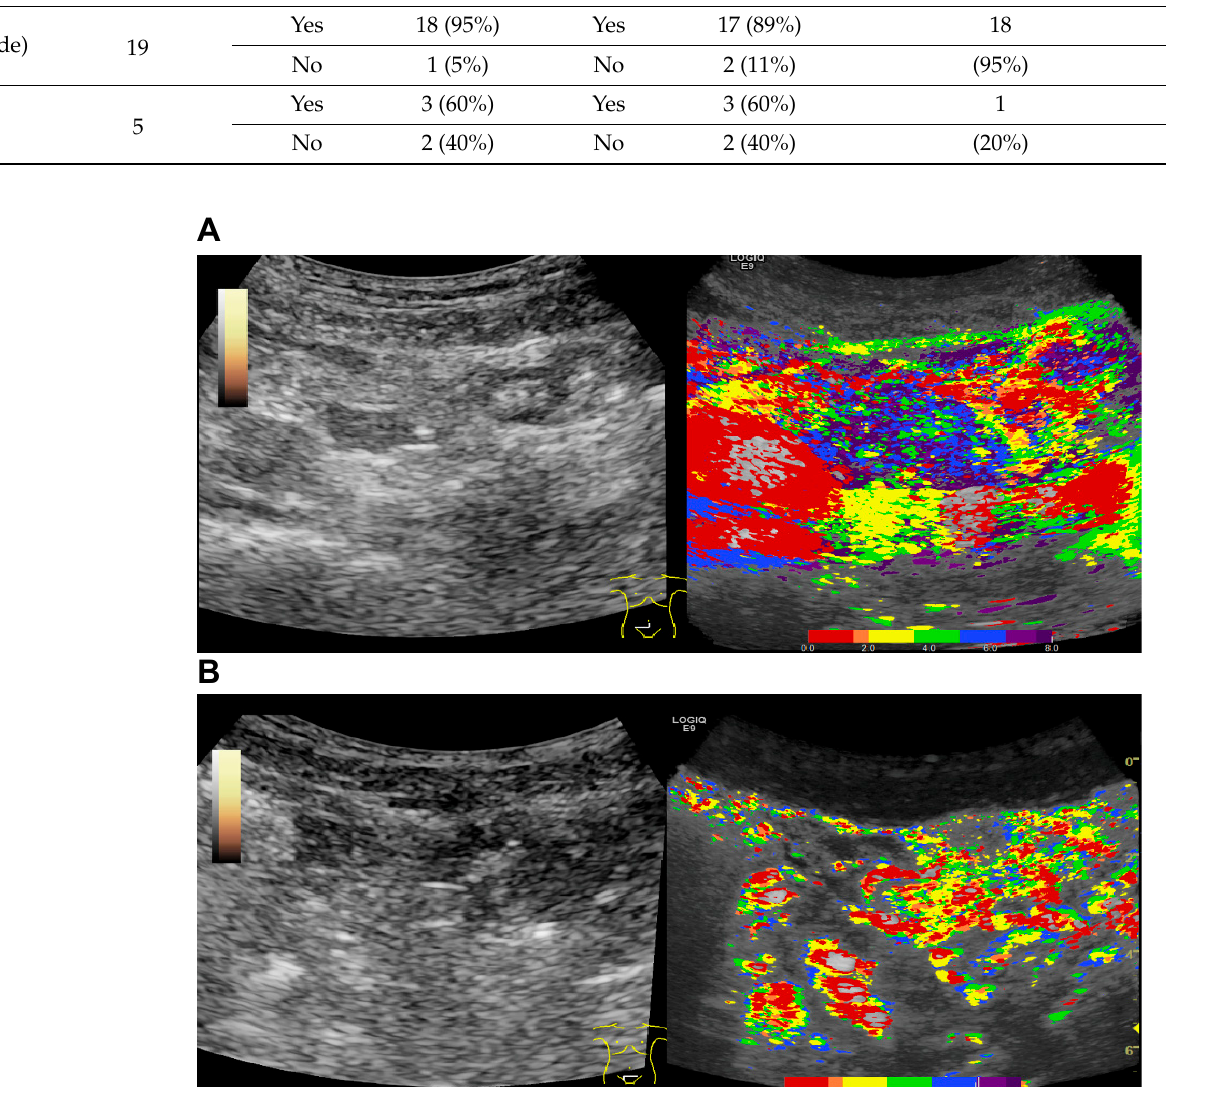
Table 3. Analysis of patients with clinical suspicion for acute GI GvHD with CEUS, CEUS with parametric imaging, histopathology, and treatment decision. GI GvHD Histology Result.